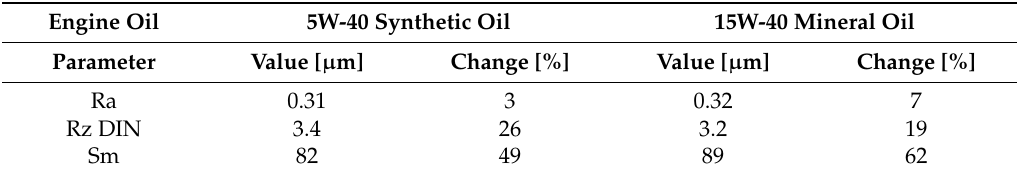
Table 4. Roughness of steel ring specimens after the test under pressure of 20 MPa (DIN 4768, ISO 4287). Engine Oil